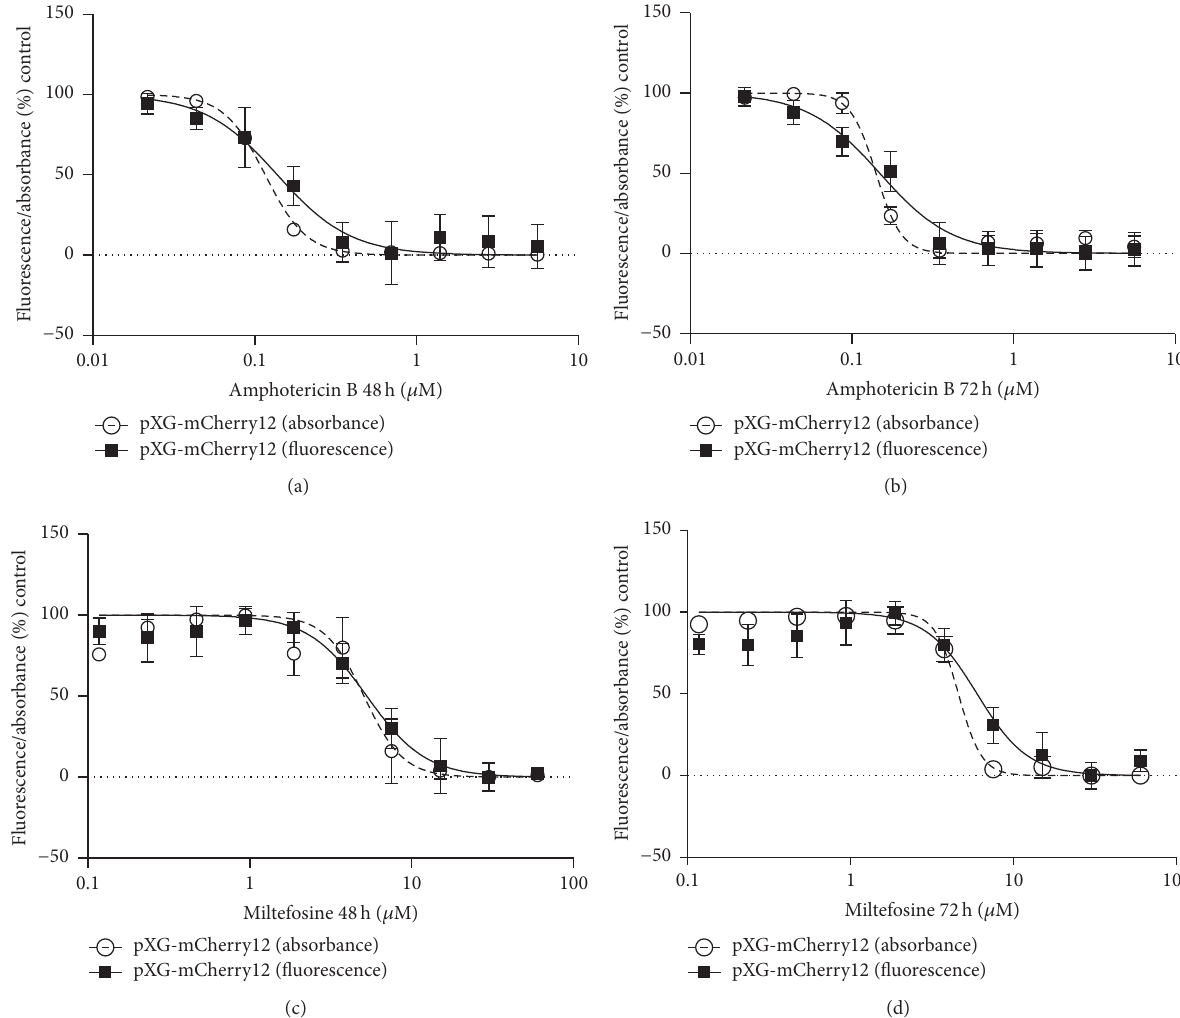
Figure 5: mCherry fluorescence is a valuable tool for measuring cell viability. Two pharmacological compounds were tested: amphotericin B (aandb)andmiltefosine(candd).NonlinearregressioncurvefitforMTT(absorbance)andmCherry(fluorescence)isshown.Measurements were performed after 48 and 72 h for each drug. Plots represent the mean ( ± SD) of three independent